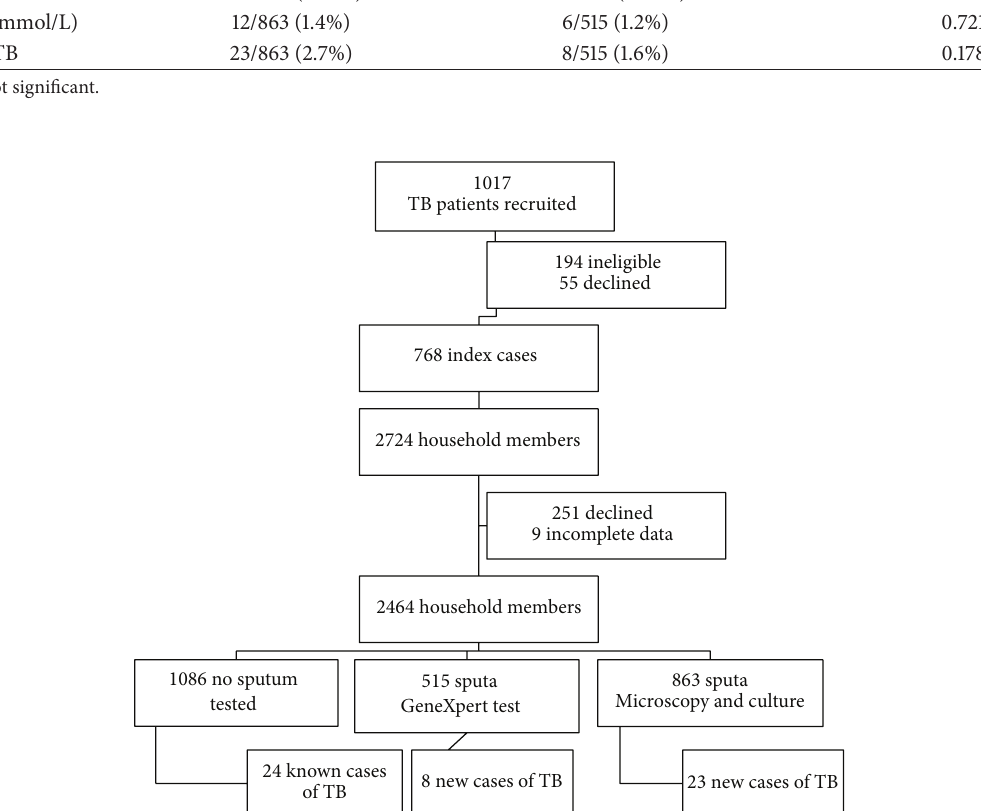
Figure 1: Flowchart of results of the study to determine if the use of GeneXpert is comparable to SLC in diagnosing TB among household contacts in active case